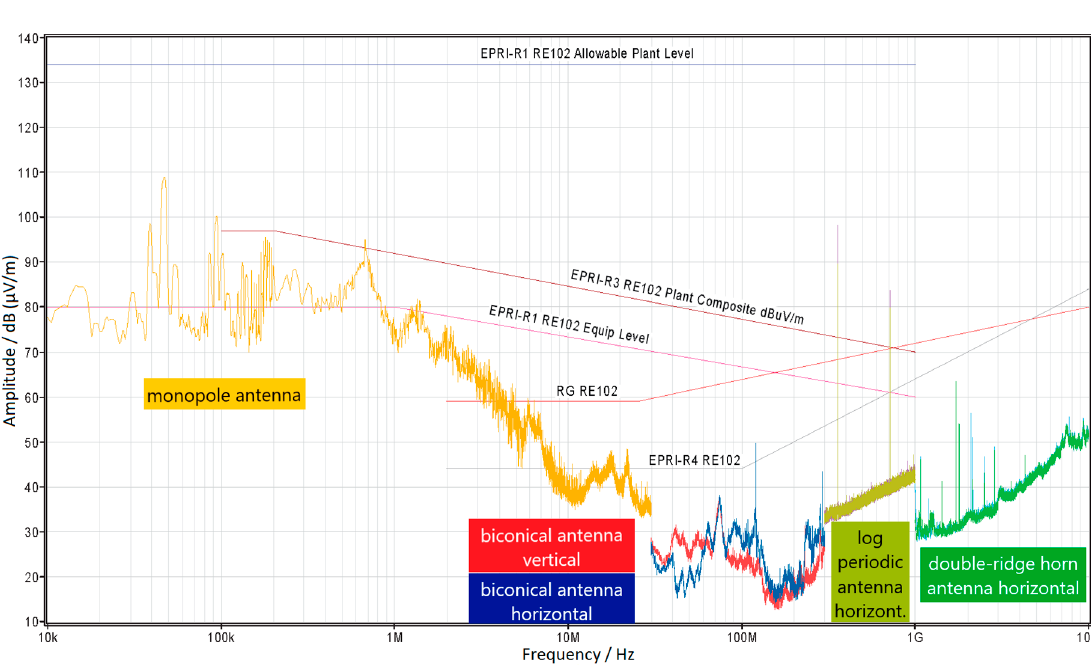
Figure 6. RE102 emissions and regulatory limits for one specific plant room (combined emissions captured by three